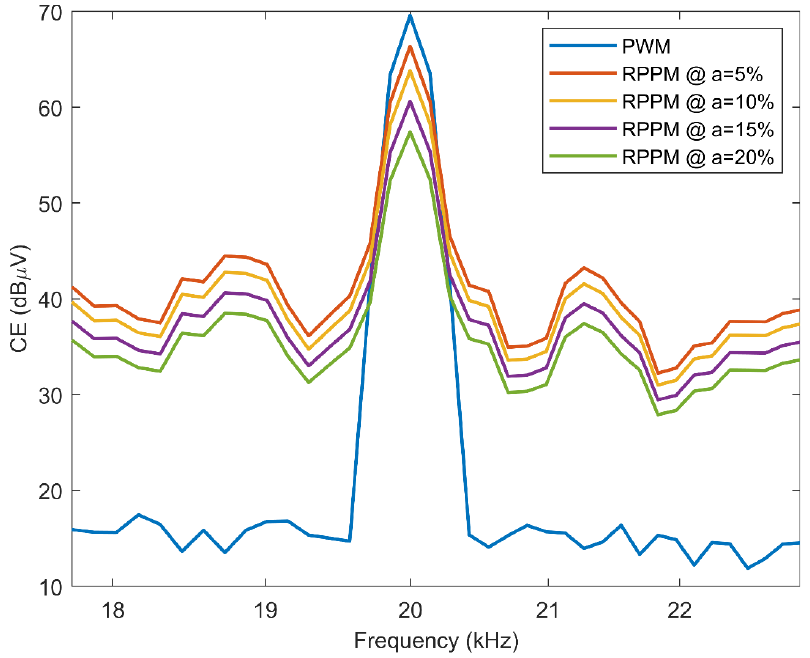
Figure 11. CE of the DC-DC converter measured with different values of the modulation index at 20 kHz switching frequency and at 33% RNUR.